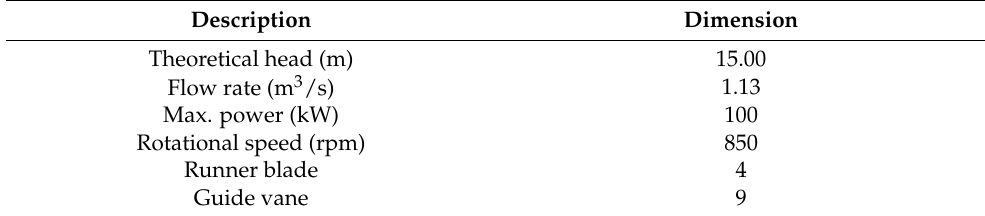
Table 1. Design specifications of the tubular turbine.